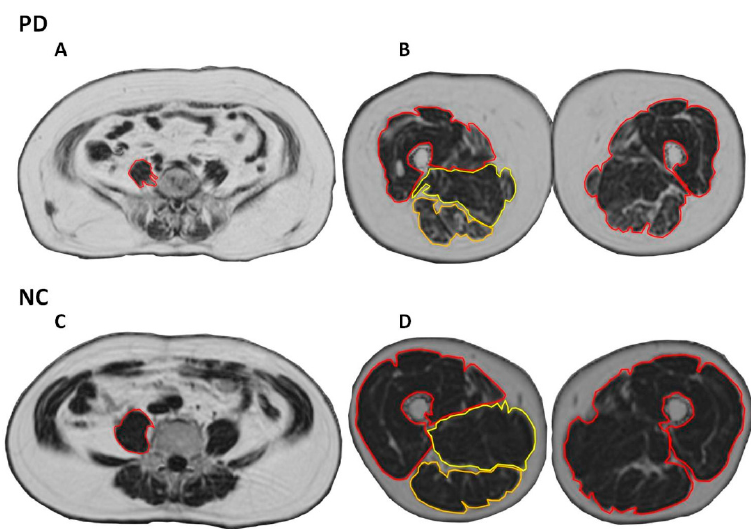
Figure 1. The regions of interest (ROI) of IDEAL fat fraction map images. The ROI included bilateral psoas muscles, and three compartments and the total of bilateral thighs. A and C : Psoas muscles. B and D : Three compartments of thigh. Abbreviations: NC: normal control; PD: Parkinson’s disease.